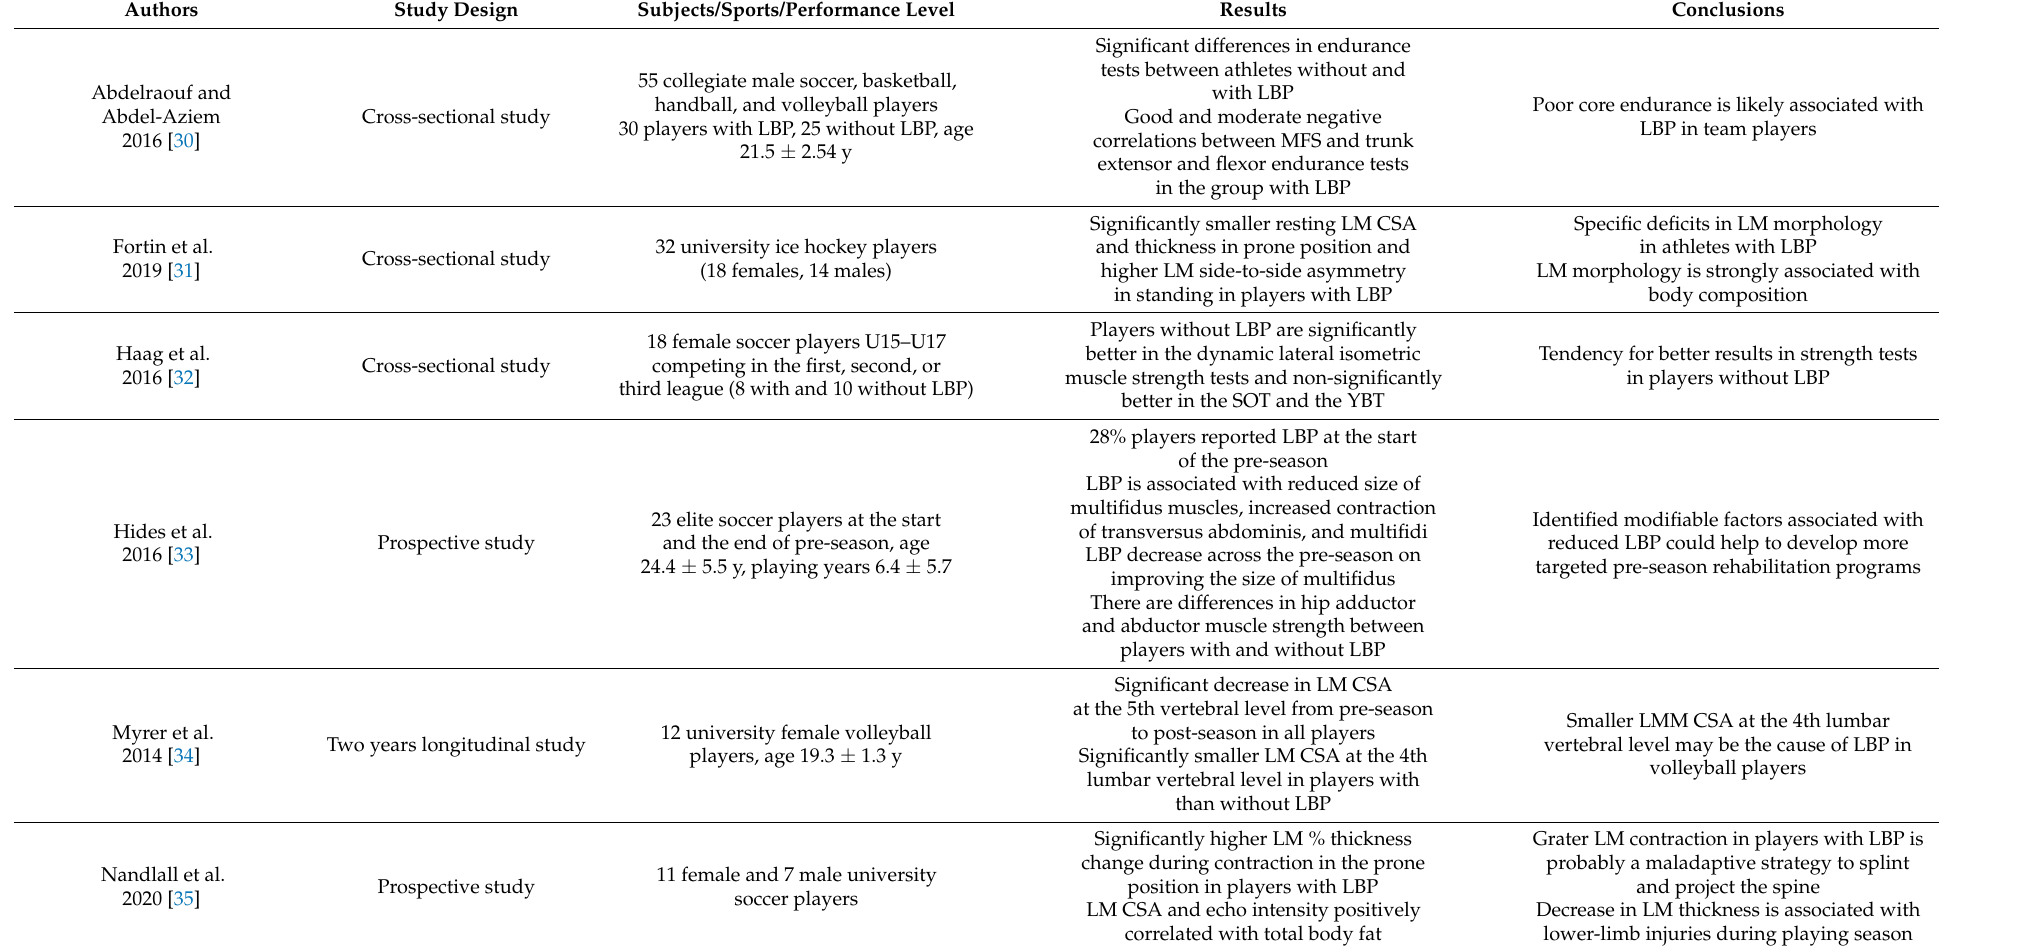
Table 1. Relationships between core characteristics and LBP in team